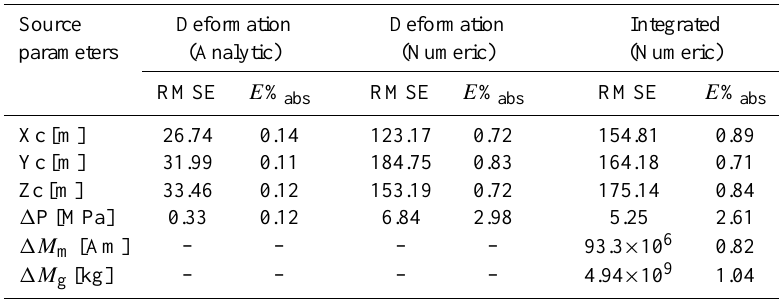
Table 2. Performance indexes RMSE and E % abs for the inversion of analytical and numerical deformation model and for the integrated numerical